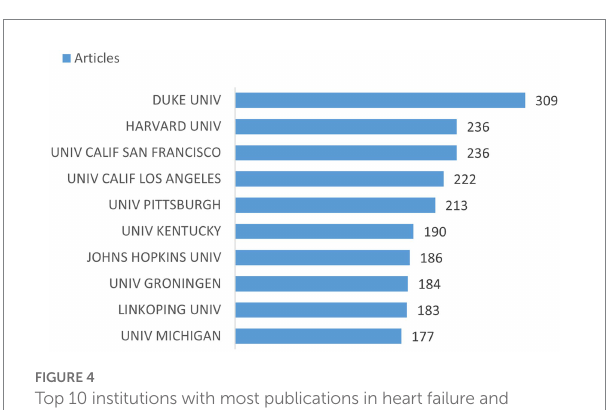
FIGURE 4 Top 10 institutions with most publications in heart failure and